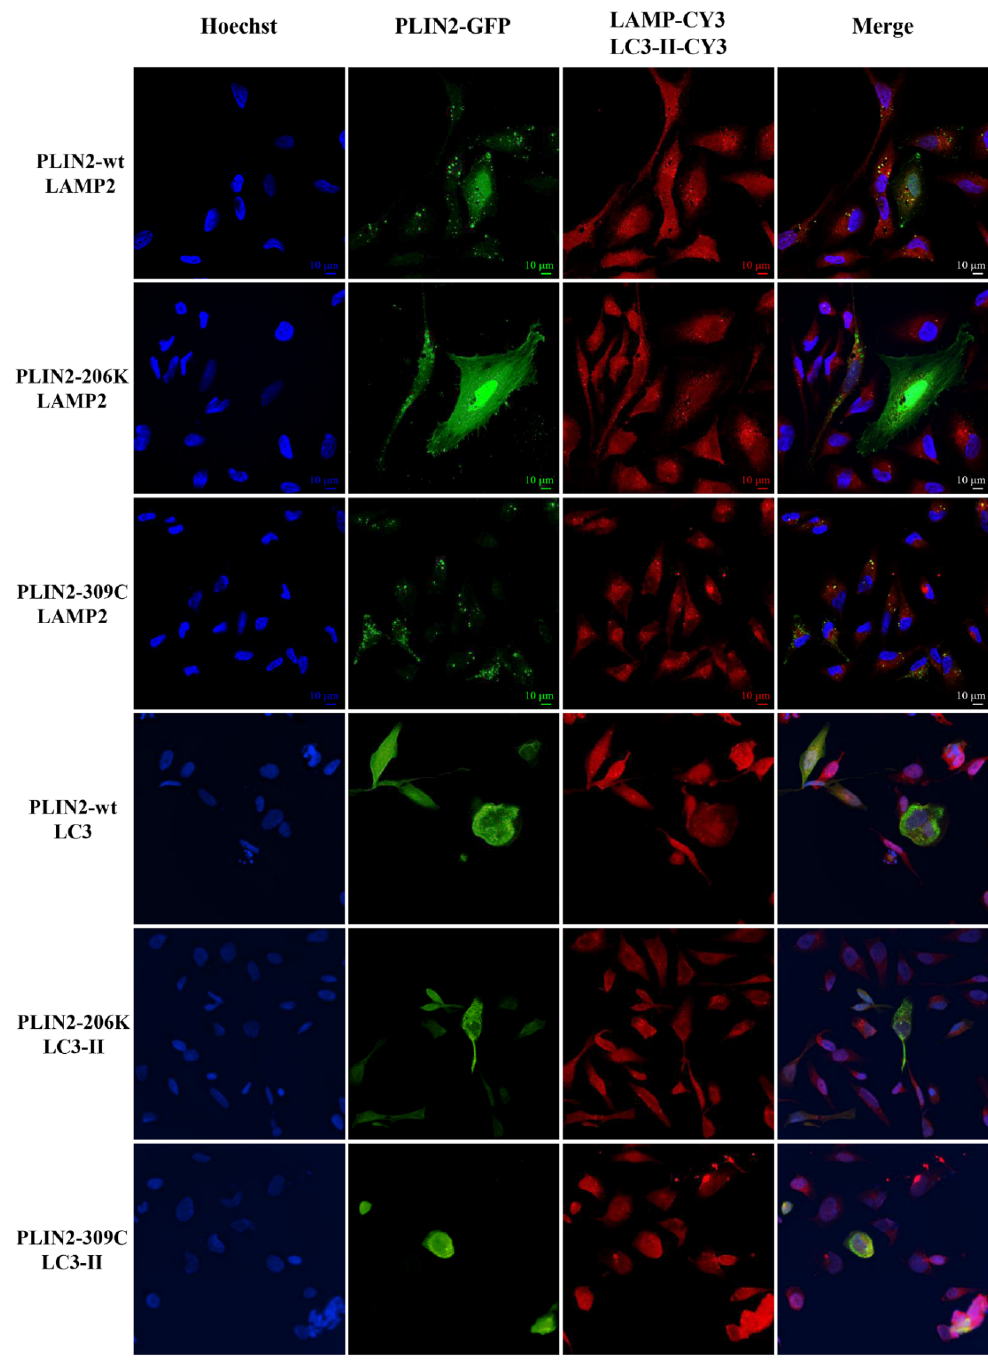
Figure 11. Immuno-localization of the PLIN2 wt (PLIN2-GFP) and mutant (PLIN2-206K-GFP) and (PLIN2-309C-GFP) proteins in the HeLa cells wt and mutant. PLIN2 proteins were fused to the green fluorescent protein (GFP), and LAMP2 and LC3 proteins were stained using anti-LAMP2/CY3 and anti-LC3/CY3. Nuclei were stained with Hoechst. Slides were visualized with a Nikon Confocal Microscope A1R at 60 × magnification (LAMP2) and with Nikon Eclipse Ni-E 40x magnification (LC3-II). The localization of the PLIN2 wt and mutant proteins is indicated by green spots spread all over the cytoplasm. PLIN2 wt protein is localized in peripheral spots as well as weakly in the nucleus. The PLIN2-206K mutant protein is expressed intensely in the nucleus in several cells, while the PLIN2-309C mutant protein was observed only as peripheral